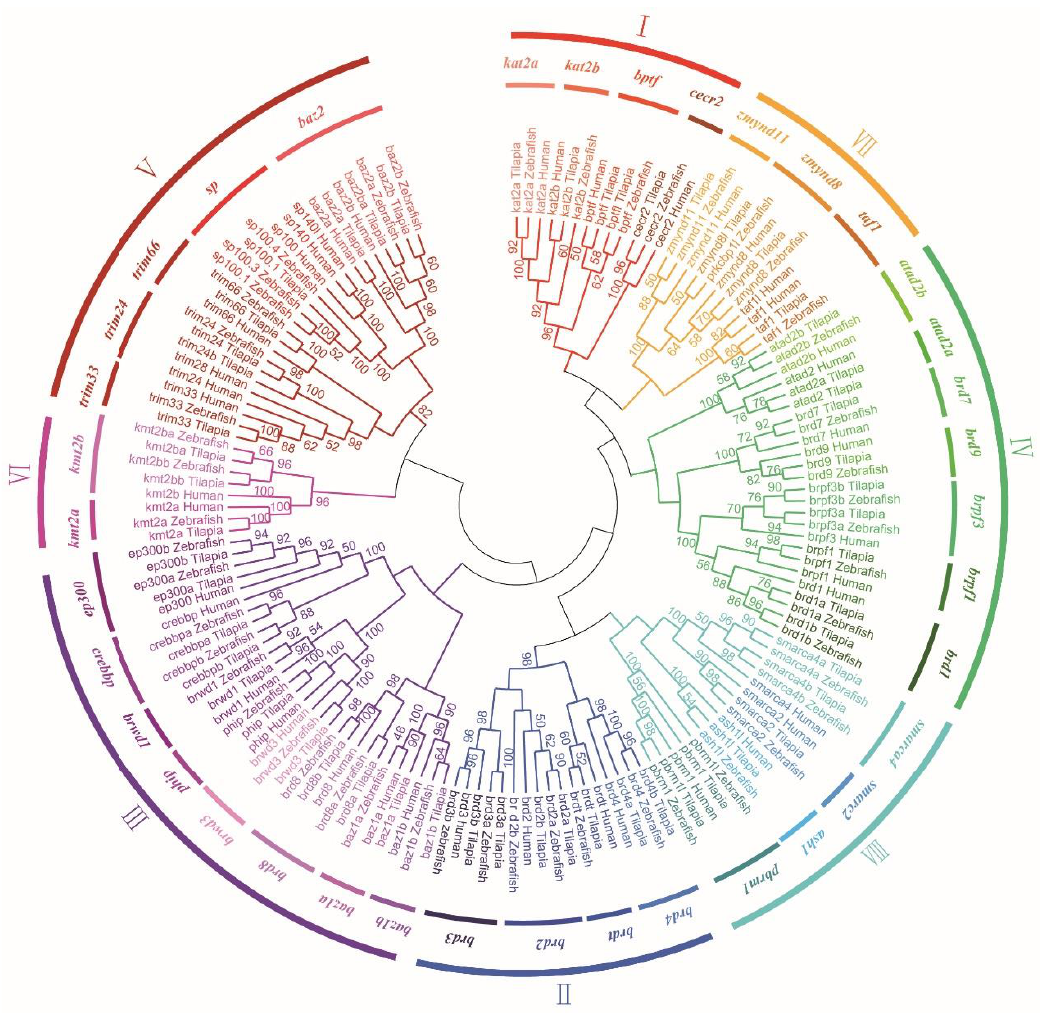
Figure 2. Phylogenetic tree of BRD family members of tilapia, humans and zebrafish. BRD family was divided into eight subfamilies ( Ⅰ – Ⅷ ). Numbers represent the bootstrap value. BRD protein sequences were aligned using Bioedit. The tree was constructed using NJ method in Mega 7.0. GenBank accession numbers are listed in Table S1.